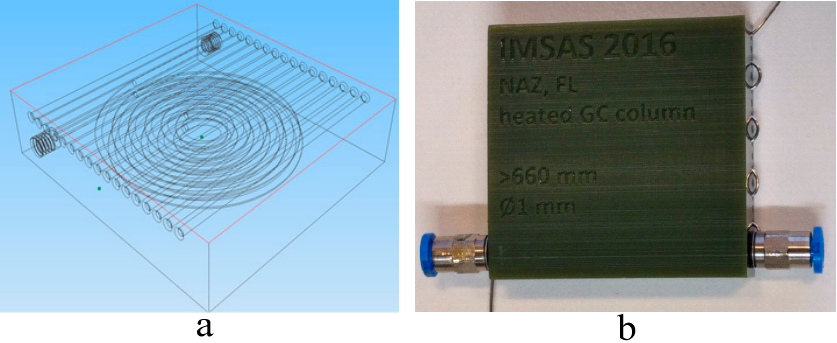
Figure 5. ( a ) Computer-aided design CAD gas chromatographic column diagram; ( b ) a printed